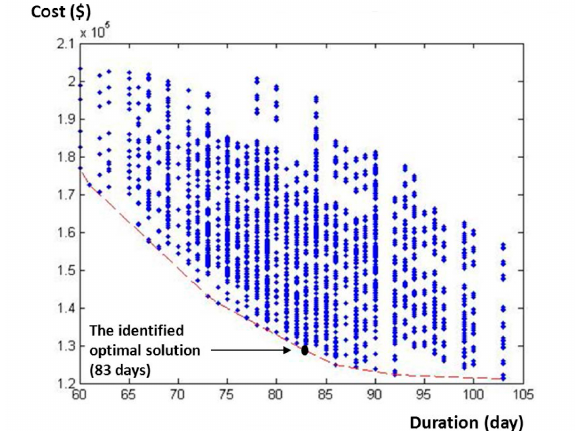
Fig. 9. All possible